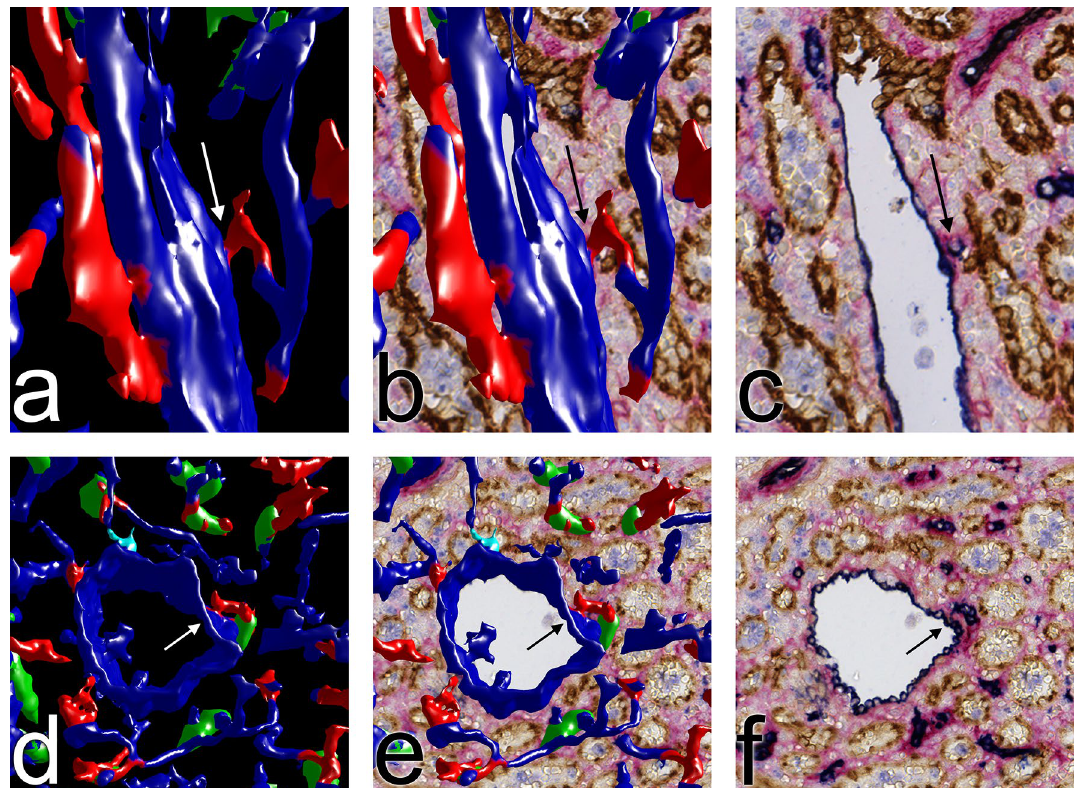
Figure 8. Two open capillary ends near venules in ROI 4. ( a – f ) Arrows indicate capillary ends in the 3D model artificially fused to the venular endothelium because of a small end process approaching the venule wall as evident in ( c ) and ( f ). For full evaluation of the sequential sections containing the capillary ends see Supplementary videos S5, S6. All capillaries artificially fused to three venules were inspected and compared to the registered sections. Among these, only three ends (cyan in Fig. 4d and in Supplementary file S4) could not be unequivocally identified as separate from the venular wall.